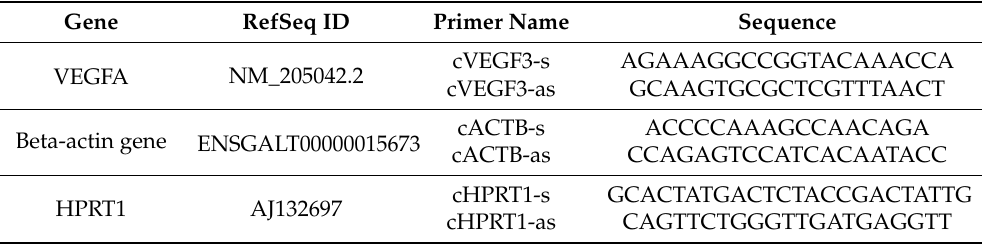
Table 1. Primers used for quantitative real-time polymerase chain reaction. Gene RefSeq